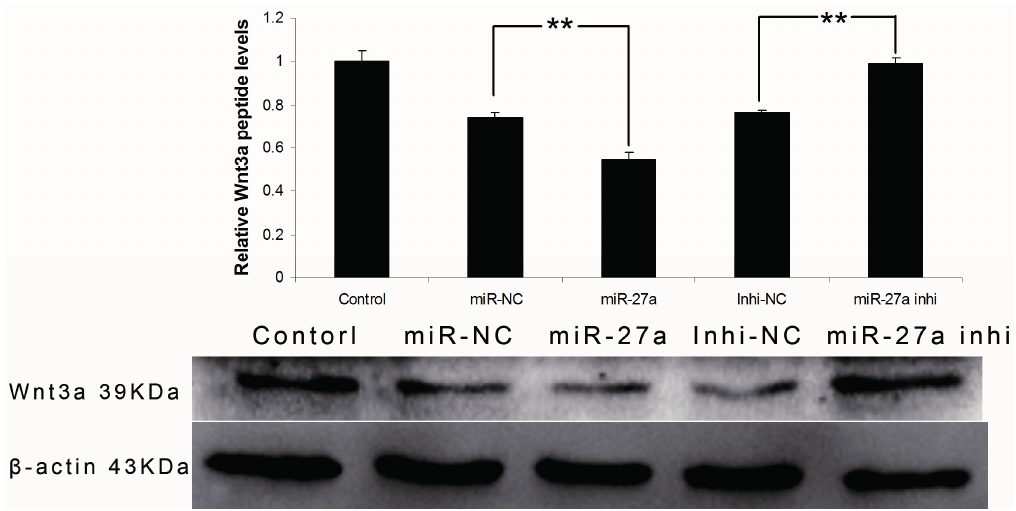
Figure 4. Expression levels of Wnt3a protein in melanocytes transfected with miR-27a mimic or inhibitor as well as their controls. Treated cells were divided into 5 groups: miR-NC, miR-27a, Inhi-NC, miR-27a inhi and untransfected control. Values represent the mean ± SE from four independent experiments. ** p < 0.01.